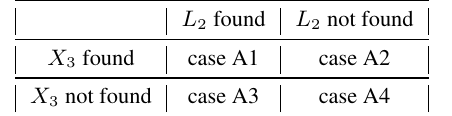
Table 5: All possible results in the first geometry test.